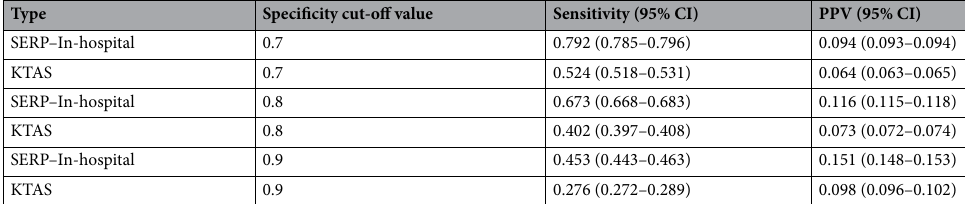
Table 3. Comparison of prediction model accuracy with same specificity point. KTAS Korea Triage Acuity Scale, SERP Score for Emergency Risk Prediction (in-hospital mortality outcome here), CI Confidence Interval PPV Positive predictive